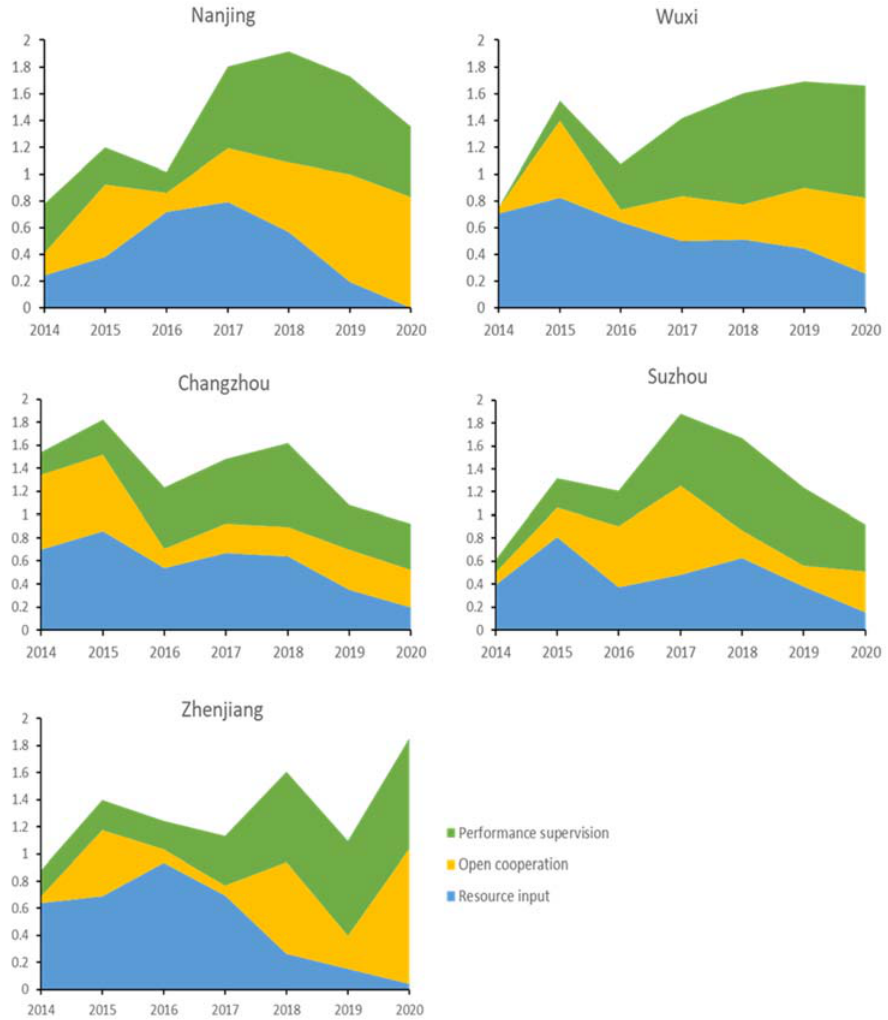
Figure 9. The order degrees of WCG subsystems within cities during 2014–2020.